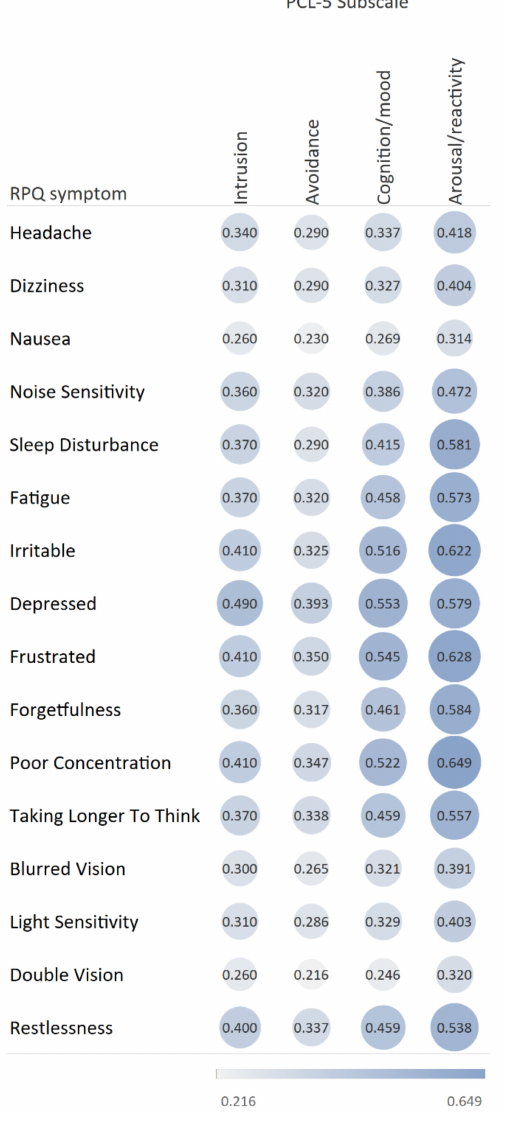
Figure 2. Spearman rank correlations between RPQ symptoms and PCL-5 subscales. All correlations were statistically significant. RPQ: Rivermead Post-Concussion Symptoms Questionnaire; PCL-5: Post-Traumatic Stress Disorder Checklist for the DSM-5. Table 2. Health-related quality of life by PC and PTSD symptom status, 6 months post-TBI. HRQoL No/Mild Severe PC Symptoms, Severe PC and Measure Symptoms 1 No PTSD 2 PTSD Symptoms